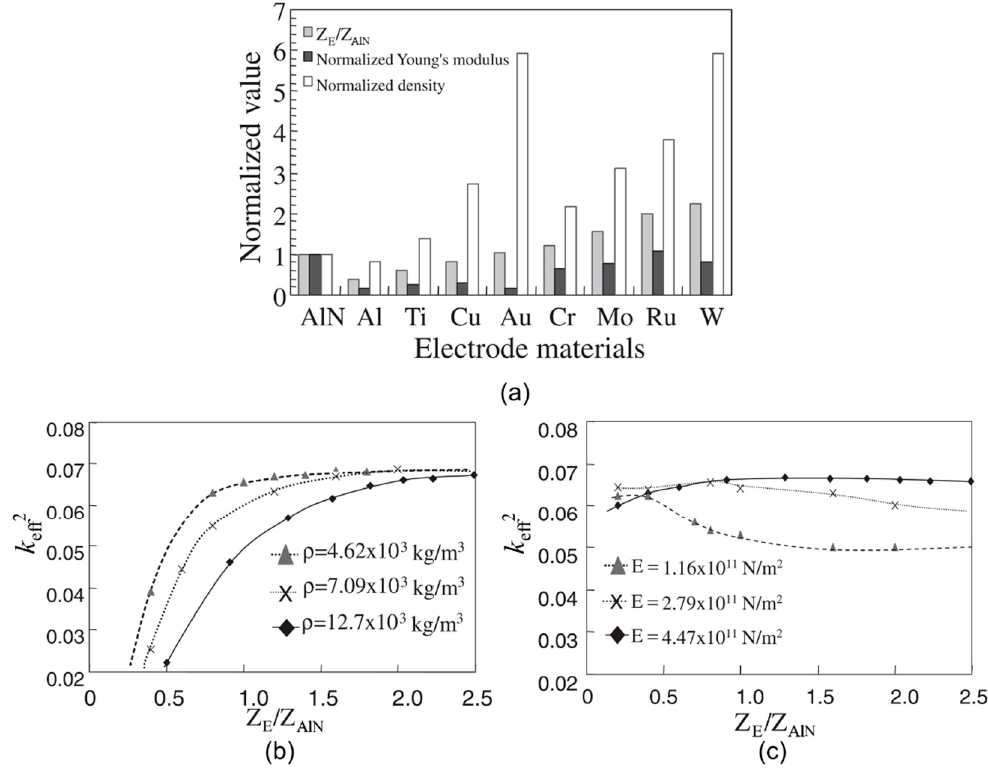
Figure 10. ( a ) Acoustic impedance, Young’s modulus, and density of electrode materials [71]. Relationship between k eff2 and normalized acoustic impedance with ( b ) ρ fixed and ( c ) E fixed [71]. Reproduced with permission from [71].